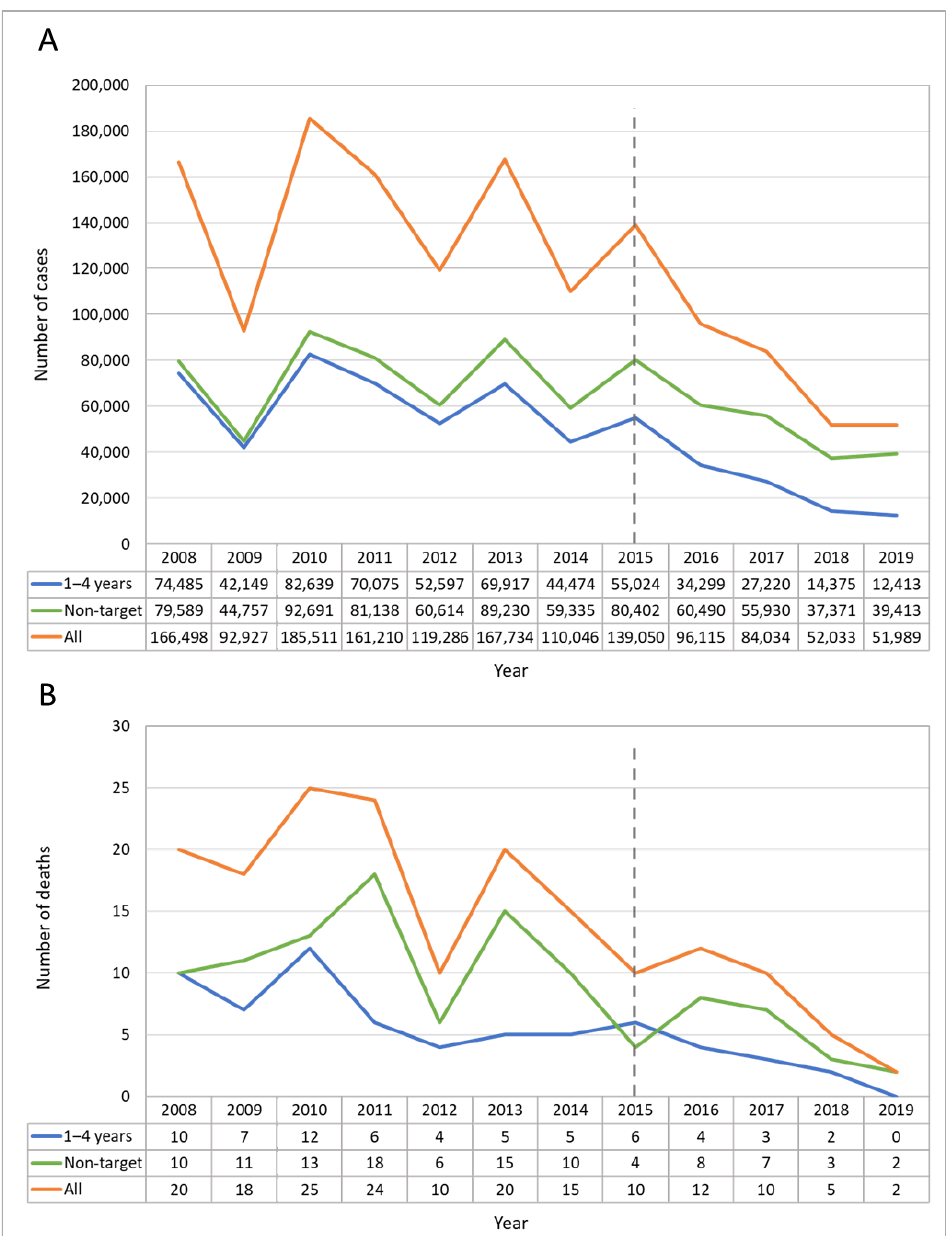
Figure 1. Pattern of reported cases of varicella ( A ) and reported varicella-associated deaths ( B ) in Argentina in the target (1–4 years), non-target (all ages excluding 1–4 years), and overall population, 2008–2019. Overall population data includes target population, non-target population, and cases with no age specification. The dashed line corresponds approximately to the period of UVV introduction in Argentina. UVV, universal varicella vaccination.